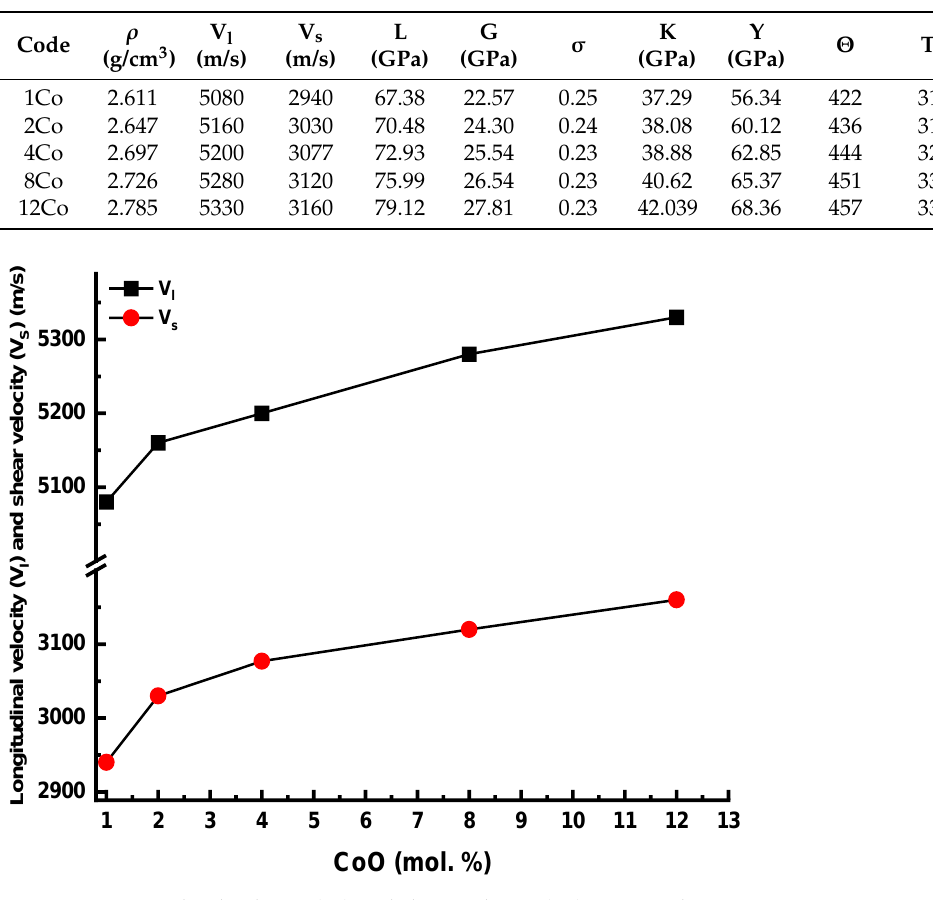
Table 3. Density, longitudinal velocity (V l ), shear velocity (V S ), longitudinal modulus (L), shear modulus (G), bulk modulus (K), Young’s modulus, Poisson’s ratio, Debye temperature, and Tg of the glasses.